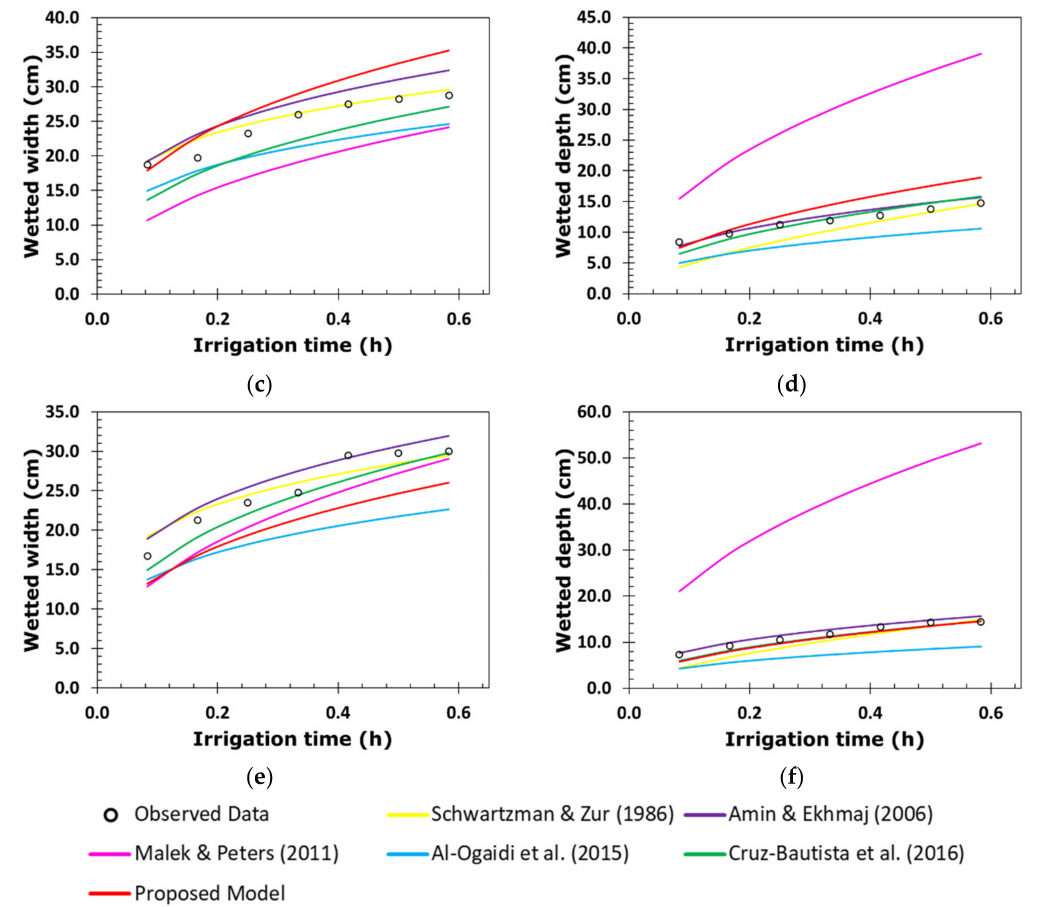
Figure 9. Temporal evolution of the width and depth of the wetting front of ( a , b ) irrigation 2B (q = 3.00 L h − 1 and θ i = 0.13 cm 3 cm − 3 ), ( c , d ) irrigation 4B (q = 3.00 L h − 1 and θ i = 0.09 cm 3 cm − 3 ), and ( e , f ) irrigation 6B (q = 3.00 L h − 1 and θ i = 0.07 cm 3 cm − 3 ) [6,10,12,13,24].